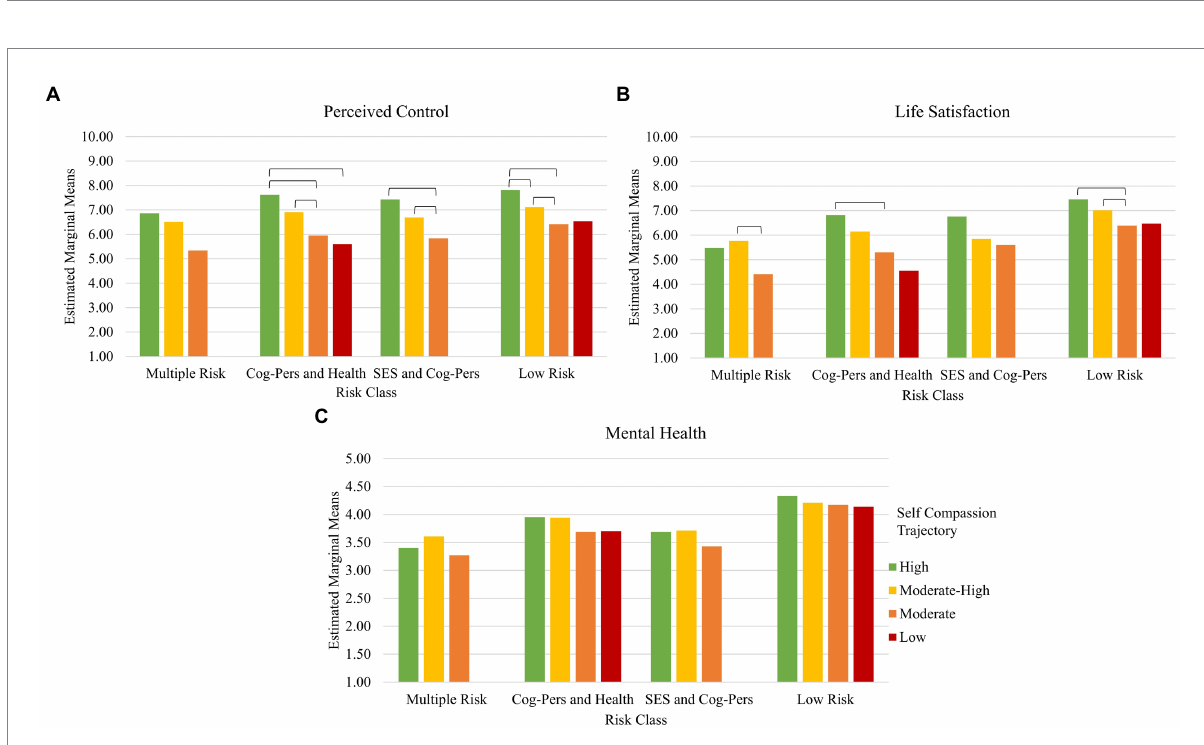
FIGURE 4 Interaction effects of risk class by self-compassion trajectory profile on wave 11 outcome variables of Perceived Control (A) , Life Satisfaction (B) , and Mental Health (C)